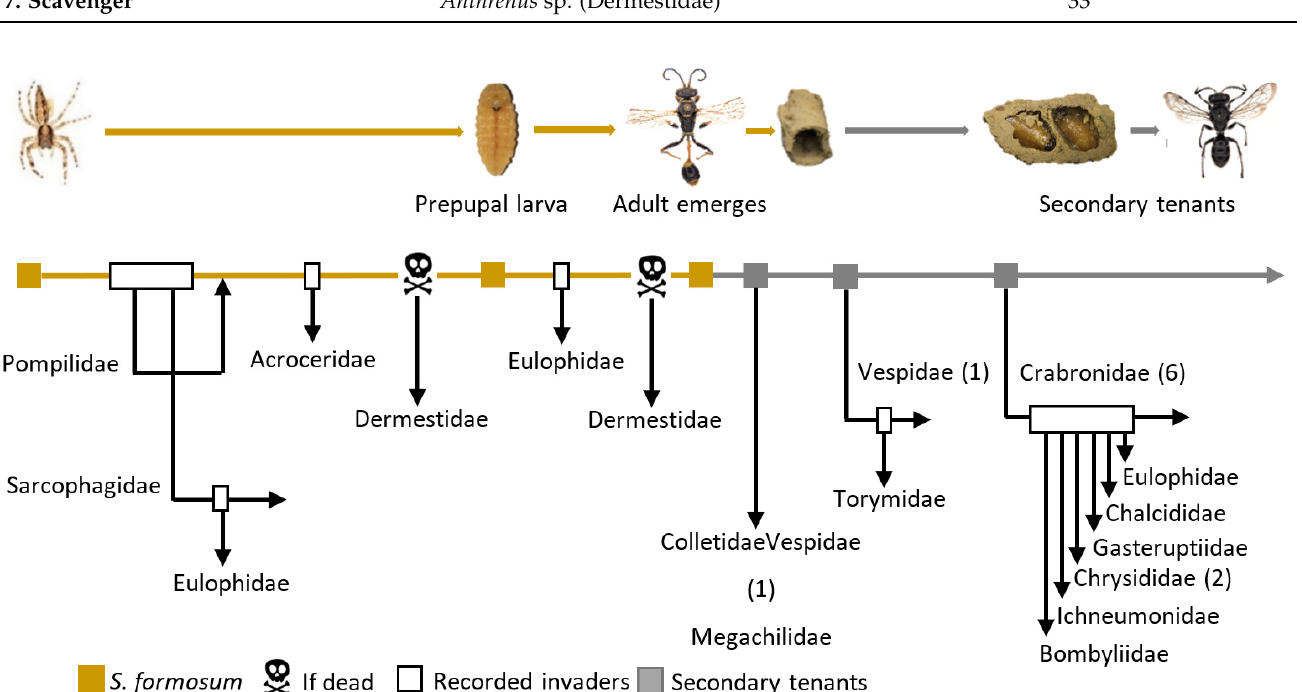
Figure 6. Insect tenants succession map within the life cycle of Sceliphron formosum mud nest. Yellow box represents the nest builder mud dauber, white box representing invasion event by parasitic insects, grey box representing the occupancy of new tenants following the emergence of mud dauber wasp adults, and skull represents the occupancy of new tenants following the death of mud dauber larvae. The number behind insect families indicates that more than one species was discovered within the family that is associated with the use of mud nests, and also shows the number of species involved at different time points.